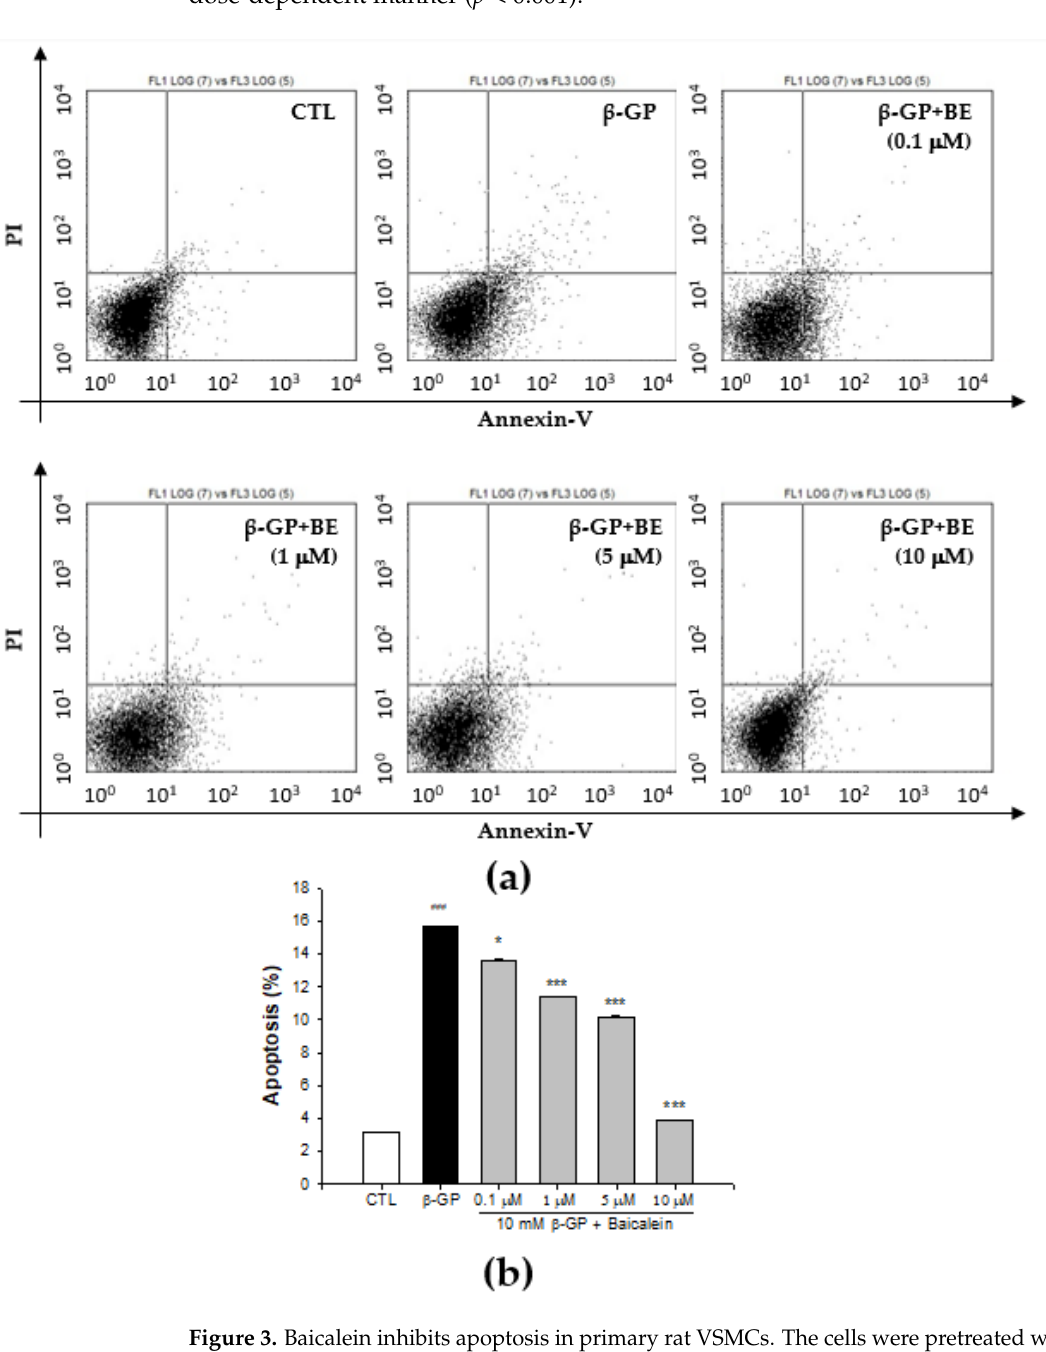
Figure 3. Baicalein inhibits apoptosis in primary rat VSMCs. The cells were pretreated with indicated concentrations of baicalein for 1 h before addition of 10 mM β -GP-induced calcification for 48 h. ( a ) The cells apoptosis determined by flow cytometry with Annexin V-PI staining. ( b ) The